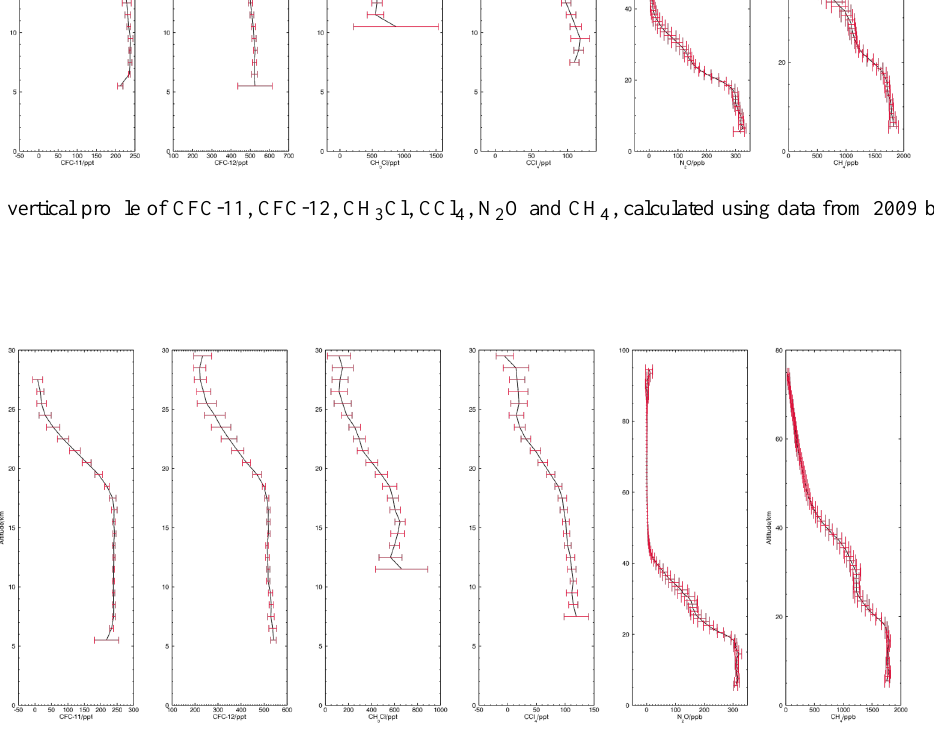
Figure C5 The mean vertical profile of CFC-11, CFC-12, CH3Cl, CH4 & N2O, calculated using data from 2009 between 30° and 15° North Fig. C6. The mean vertical profile of CFC-11, CFC-12, CH 3 Cl, CCl 4 , N 2 O and CH 4 , calculated using data from 2009 between 30 ◦ and 15 ◦ N.